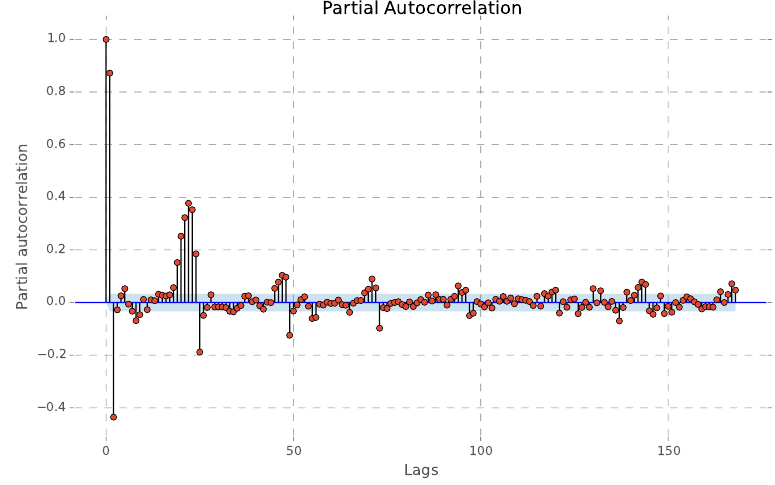
Figure 4. Partial autocorrelation of the active energy in Network 1, from Lag zero to Lag 168 (i.e., one week of hourly